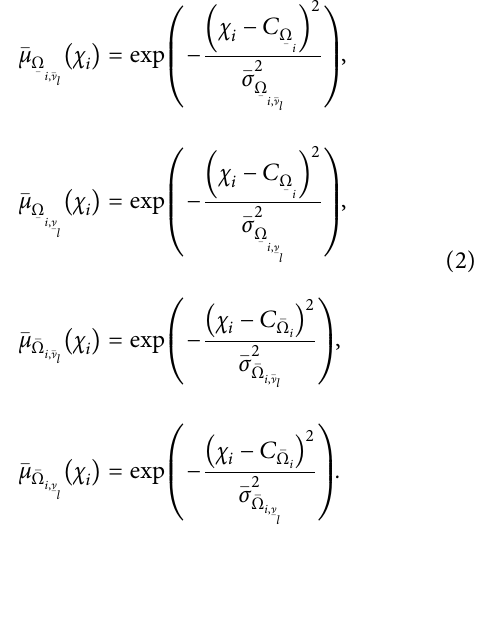
are defined as Ω and i � i and � Ω i are i � Ω and Ω , χ i � χ i